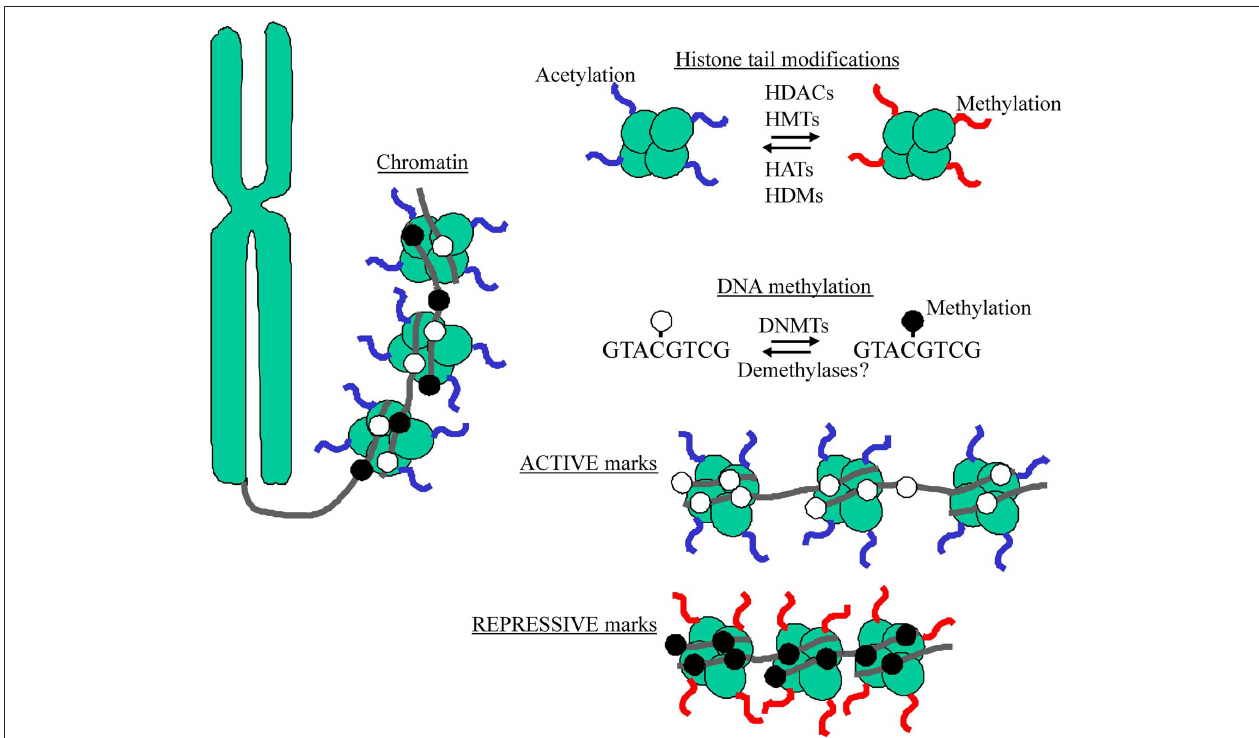
Figure 2 | DNA wraps around histones to form a complex referred to as chromatin. The N-terminal tails of histones serve as sites for epigenetic marking by acetylation and methylation via chromatin remodeling enzymes (e.g., HDACs, HATs, HMTs, and HDMs). DNA methylation refers to the chemical transfer of